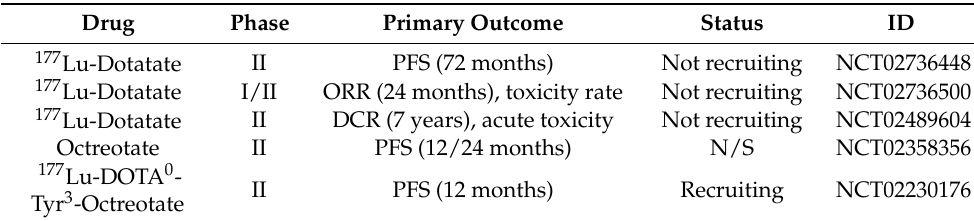
Table 2. Other clinical trials targeting the somatostatin receptor in pancreatic cancer.